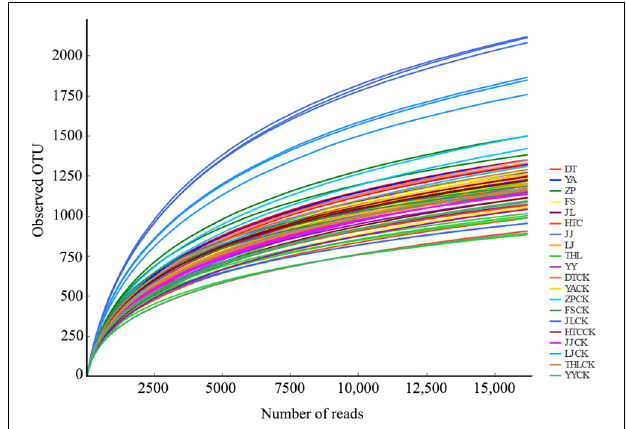
FIGURE 1 | Rarefaction curves of bacterial